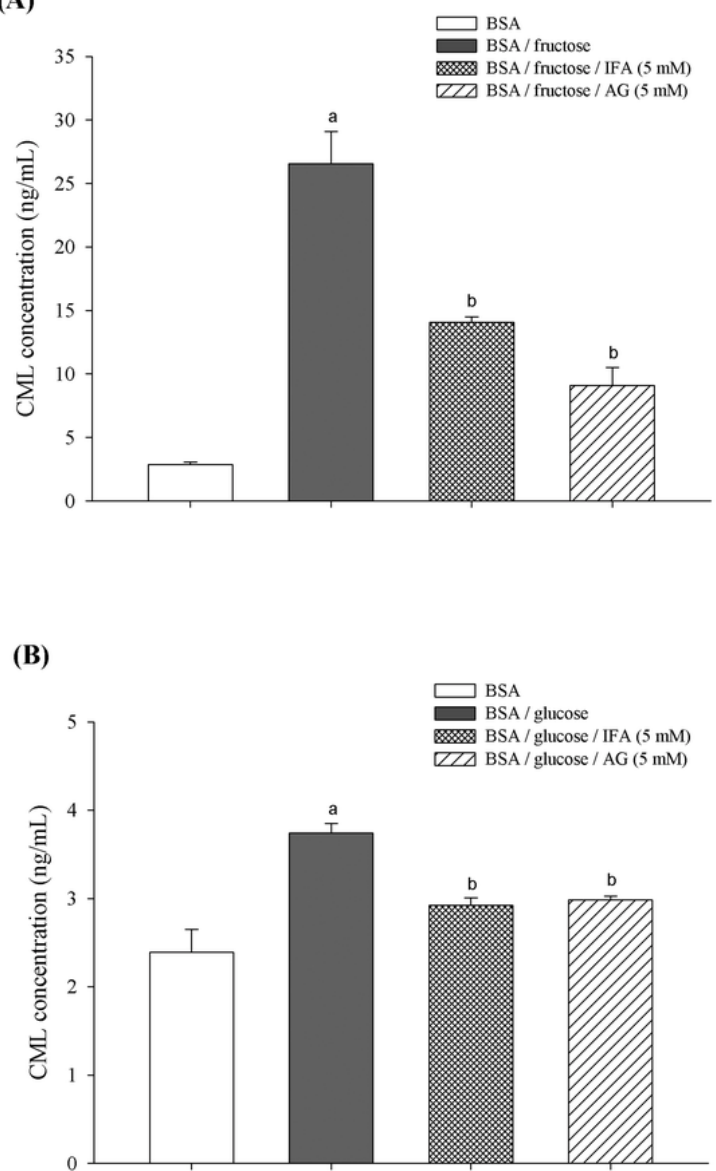
Figure 4. The effect of IFA on the formation of N ε -(carboxymethyl) lysine (CML) in BSA/fructose ( A ) and BSA/glucose ( B ) systems at week 4. Results are expressed as mean ± SEM (n = 3). a p < 0.05 when compared to BSA, b p < 0.055 when compared to BSA/fructose or